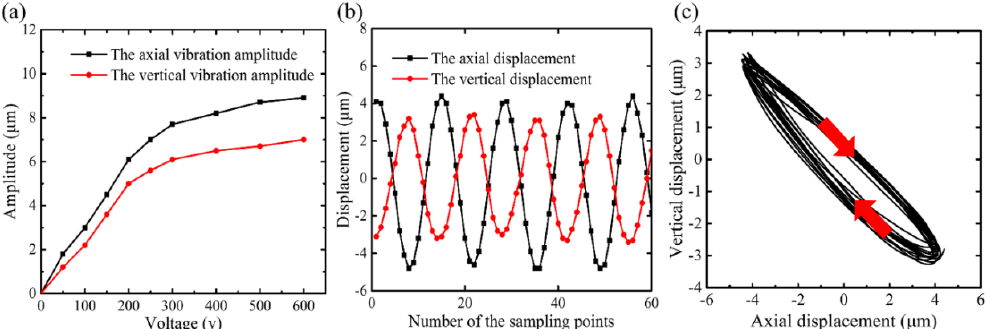
Figure 7. The vibration performance testing results of SDUEVC device. ( a ) The amplitudes in axial and vertical directions of SDUEVC device with different excitation signal voltages. ( b ) The recorded vibration displacements of the tool tip (the excitation signal voltages was 500 V p-p ). ( c ) The vibration trajectory of the tool tip.